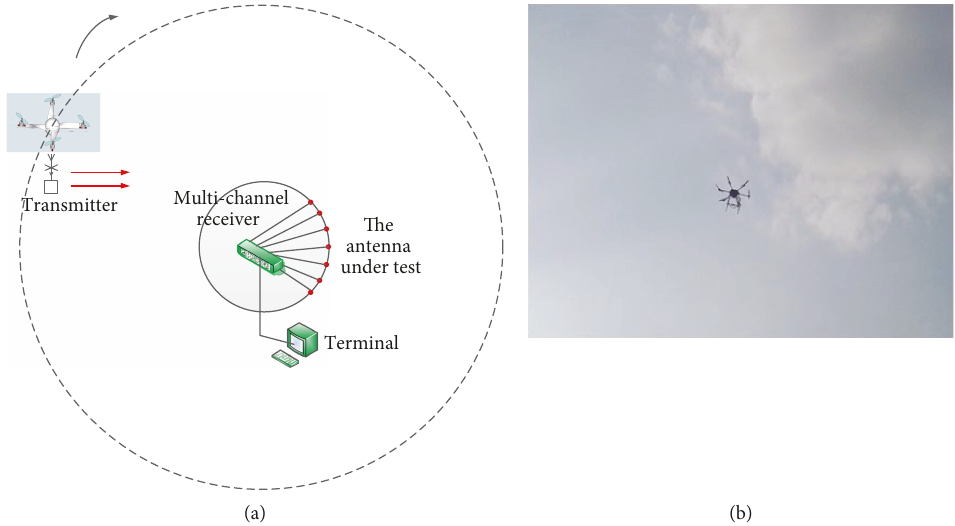
Figure 10: (a) Antenna measurement diagram and (b) the unmanned aerial vehicles at an altitude of 300m.